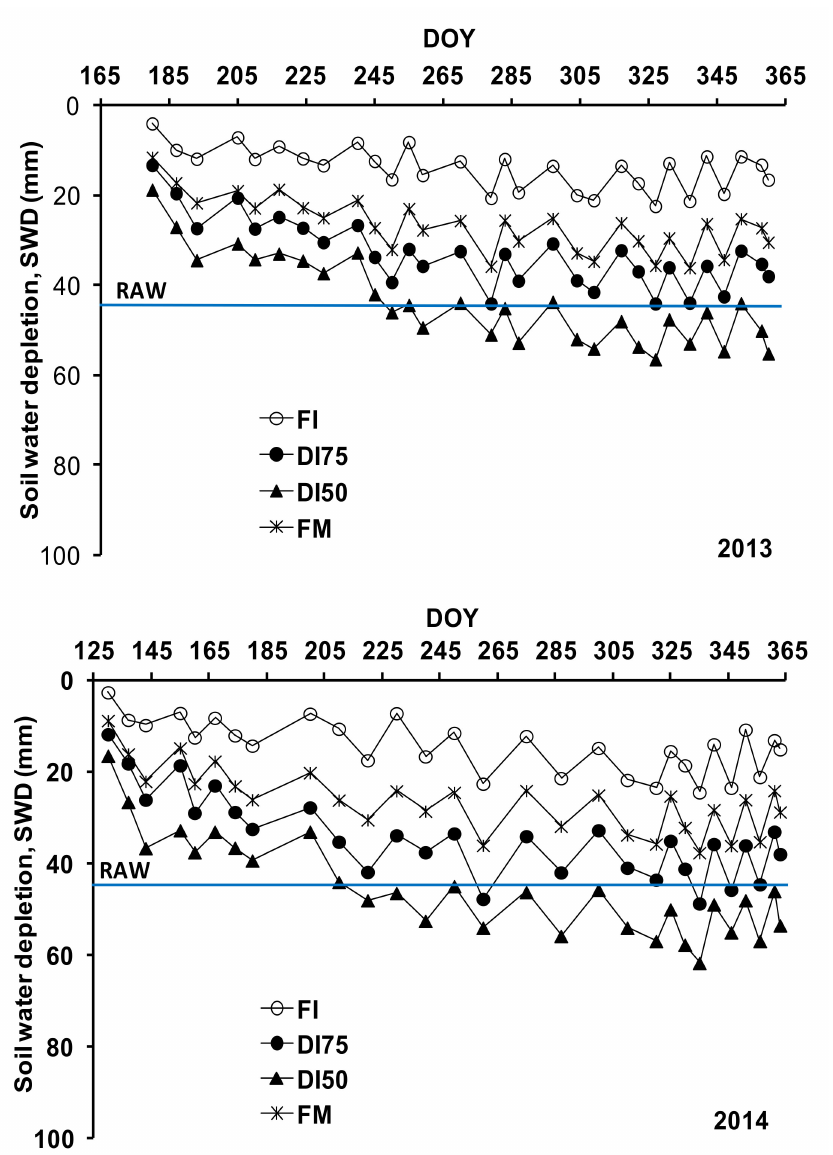
Figure 2. Soil water depletion (SWD, mm) in orange trees for the 4 irrigation treatments in 2013 and 2014. The irrigation treatments consisted of providing 100% ETc (FI), 75% ETc (DI75), 50% ETc (DI50), and grower’s irrigation program (FM); ETc was estimated by the FAO-56 method; and DOY is the day of year. Blue horizontal line represents the RAW